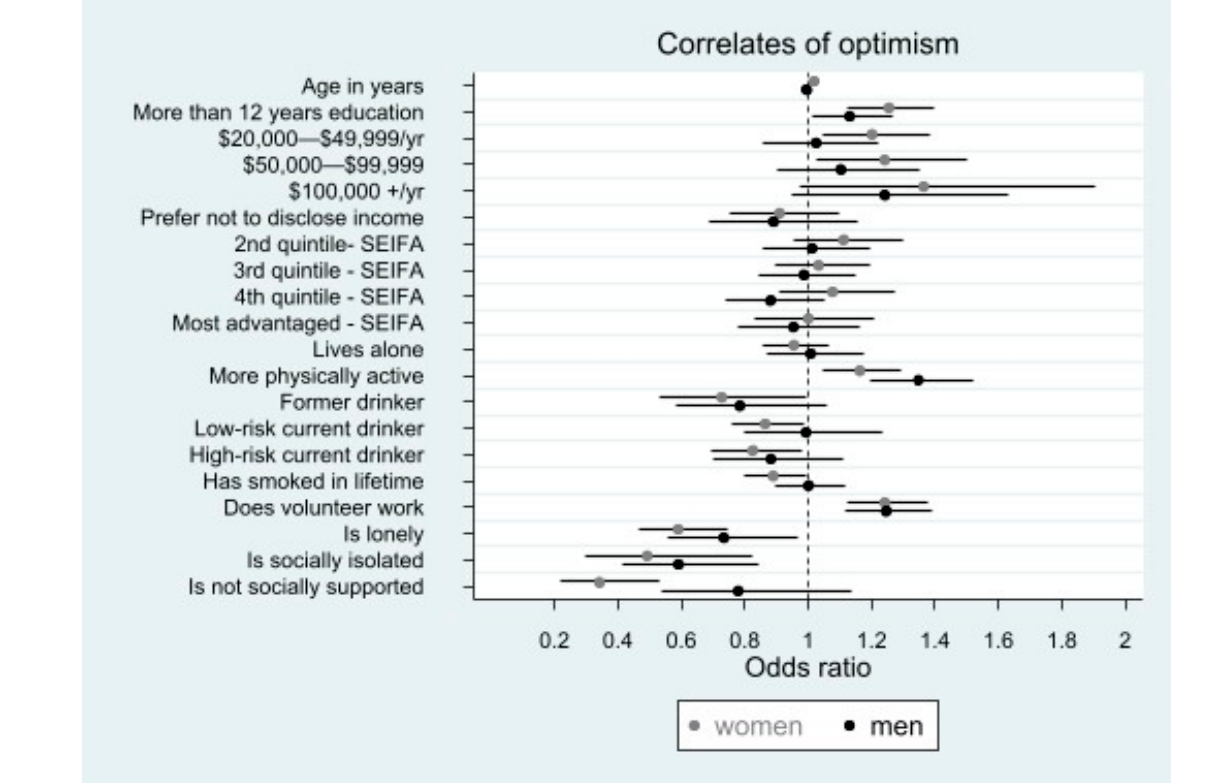
Figure 1. The association of socio-economic, behavioural, and social health factors with optimism in 10,146 men and women aged ≥ 70 years: the results of multivariable ordinal logistic regression. Footnote: Horizontal bars present 95%CIs. SEIFA: socio-economic indexes for areas Referent categories in order of variable appearance in the figure: <12 years education, <AUD 20,000/year, least advantaged, lives with others, less physically active, never drinks alcohol, never smoked, no volunteer work, not lonely, not socially isolated, and socially supported. As Figure 1 indicates, higher level of education, being more physically active, doing volunteer work, and not being lonely were associated with higher optimism compared to the referent categories for both men and women. Drinking alcohol at high risk levels was associated with lower optimism compared to the referent categories for men and women (Figure 1). For women, being older and earning AUD 20,000–99,999 compared